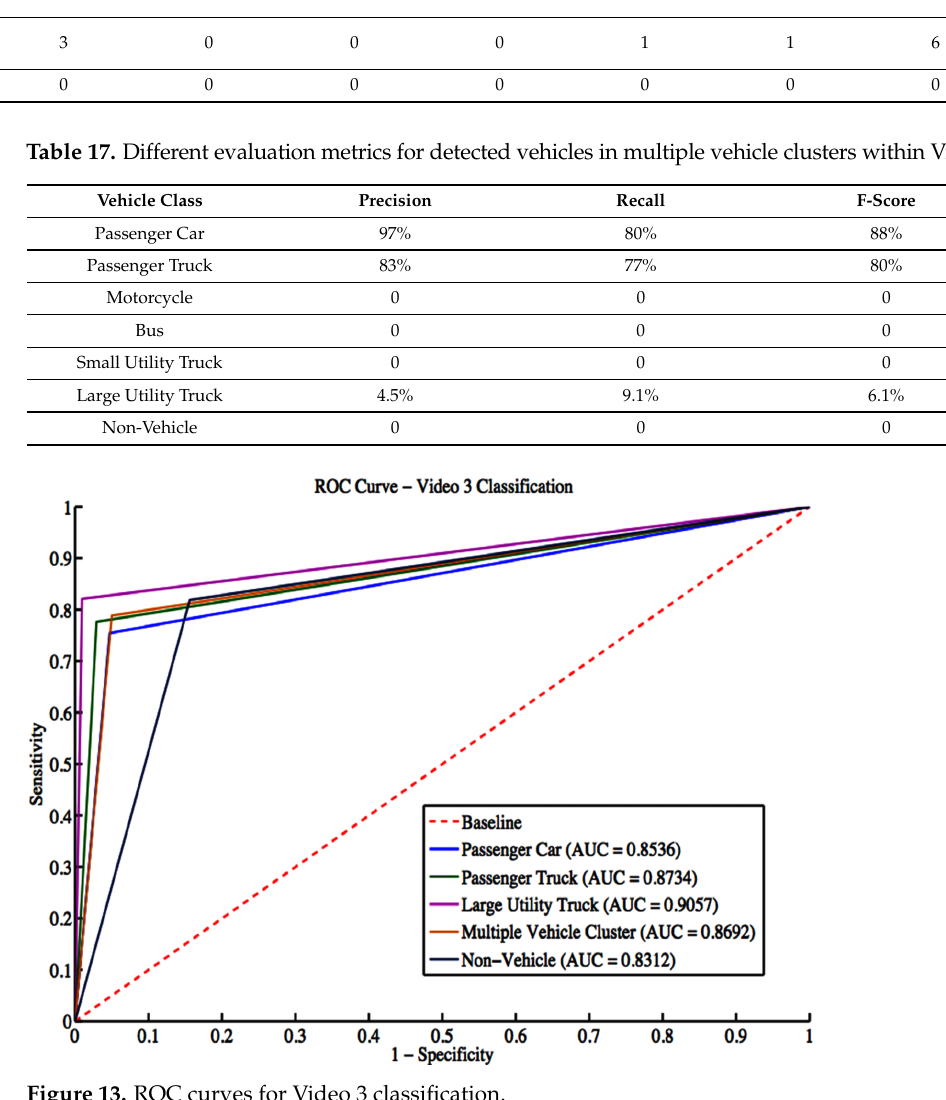
Figure 13. ROC curves for Video 3